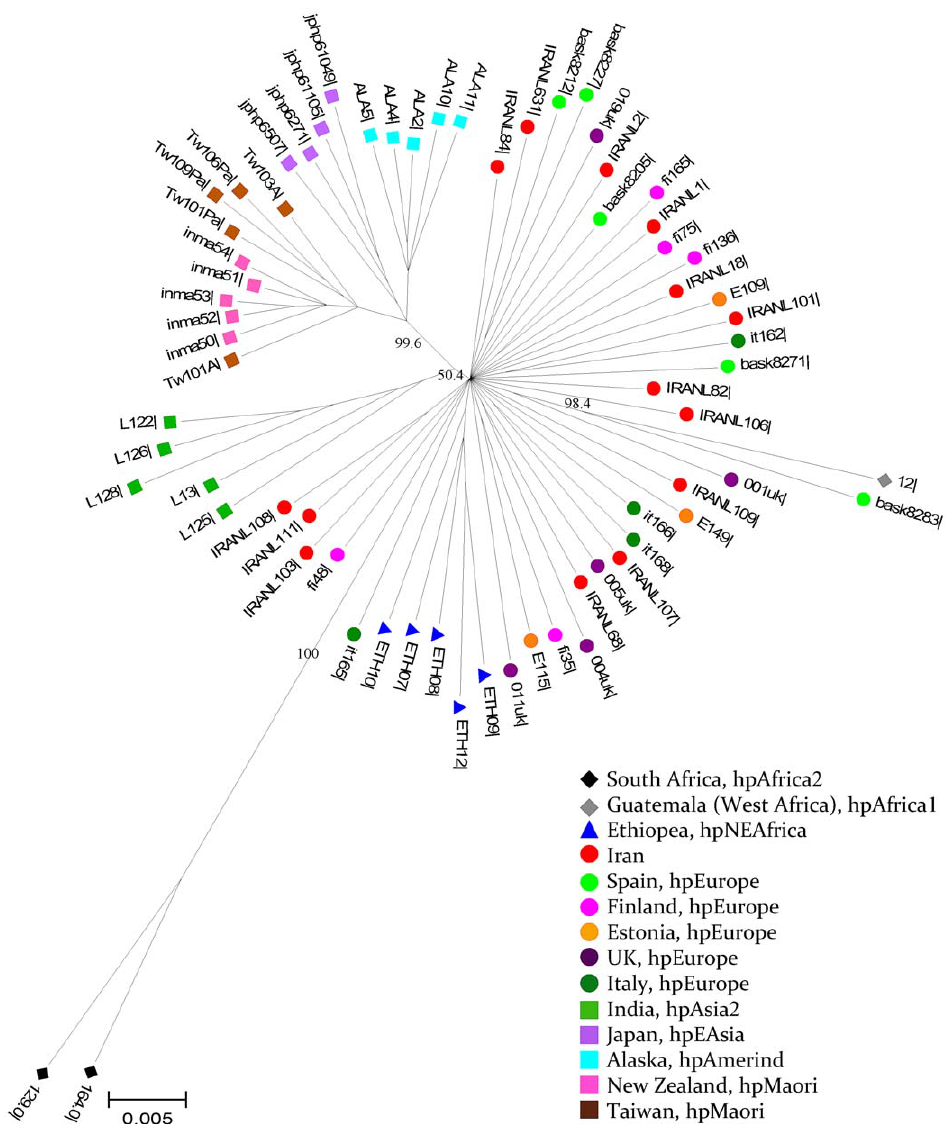
Figure 2. Neighbor-joining phylogenetic analysis of 68 worldwide H.pylori isolates using seven concatenated housekeeping gene sequences. The differentiated bacterial populations were recognized and called hpAfrica2, hpAfrica1, hspNEAfrica, hpEurope (hpEurope1 and hpEurope2), hpAsia2, hpEAsia, hpAmerind and hpMaori. The Iranian strains shared ancestral origins with the European counterparts. Each lineage is supported by a higher bootstrap value given at the corresponding branch. The strains were colour-coded according to the origins they were